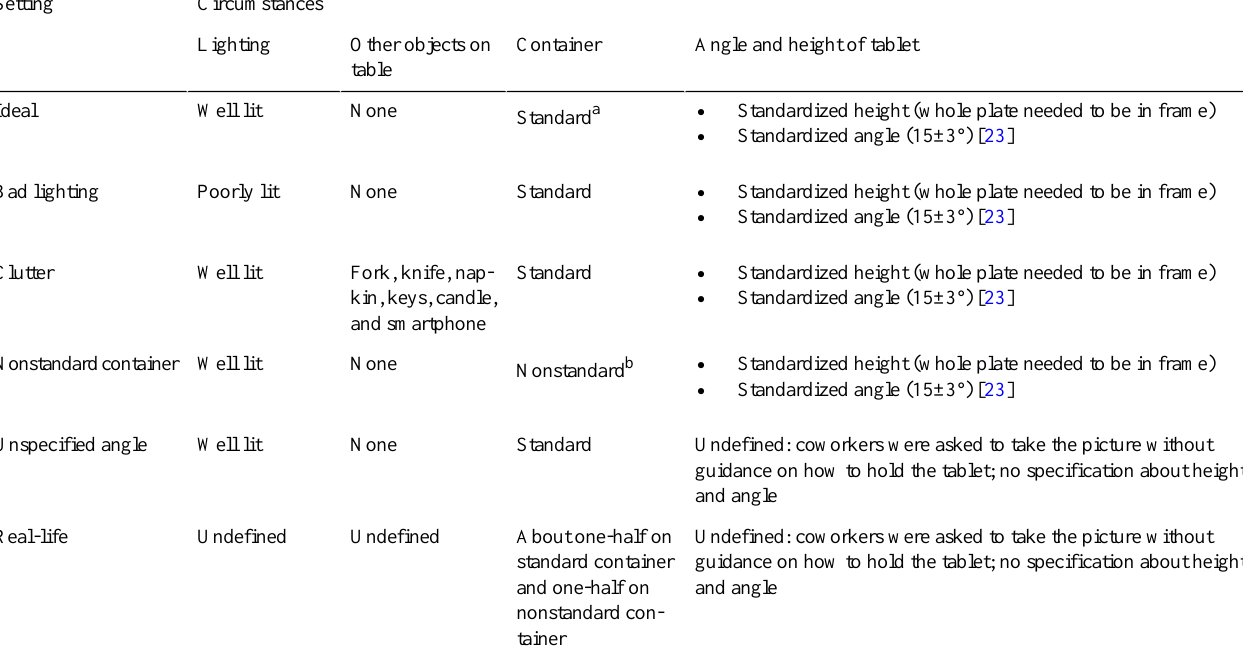
a Standard containers: white, round plate and translucent glass or white mug. a Nonstandard containers: colored glasses, plates with designs and different shapes, colored mugs, bowls made out of different materials and